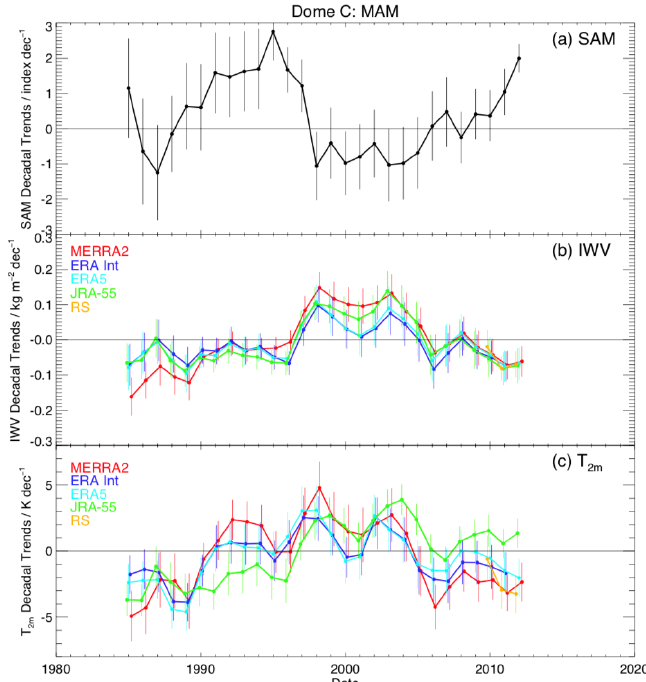
Figure 10. Multidecadal variability of the 10-year trends of ( a ) the SAM index, ( b ) the IWV and ( c ) the near-surface temperature (T 2m ) from the MERRA2 (red), ERA interim (dark blue), ERA5 (light blue) and JRA-55 (green) reanalyses above Dome C from 1980 to 2017 in autumn (MAM). Superimposed are the 10-year trends of the IWV ( b ) and the 10-m temperature ( c ) from the radiosonde data set (orange) from 2005 to 2017. Vertical bars represent 1- σ error.